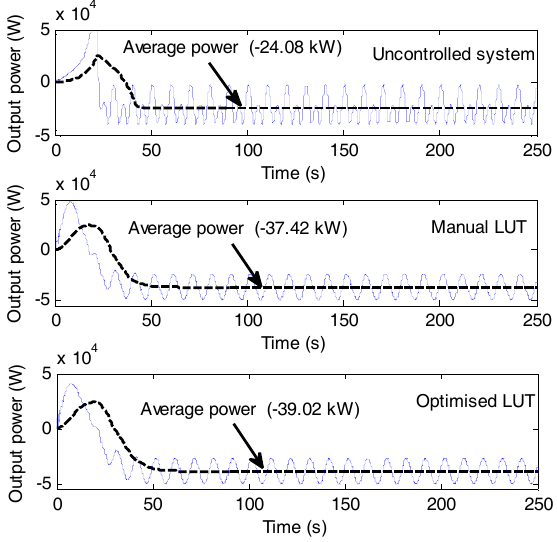
Figure 9. Flow coefficient for MPPT algorithm under regular waves.